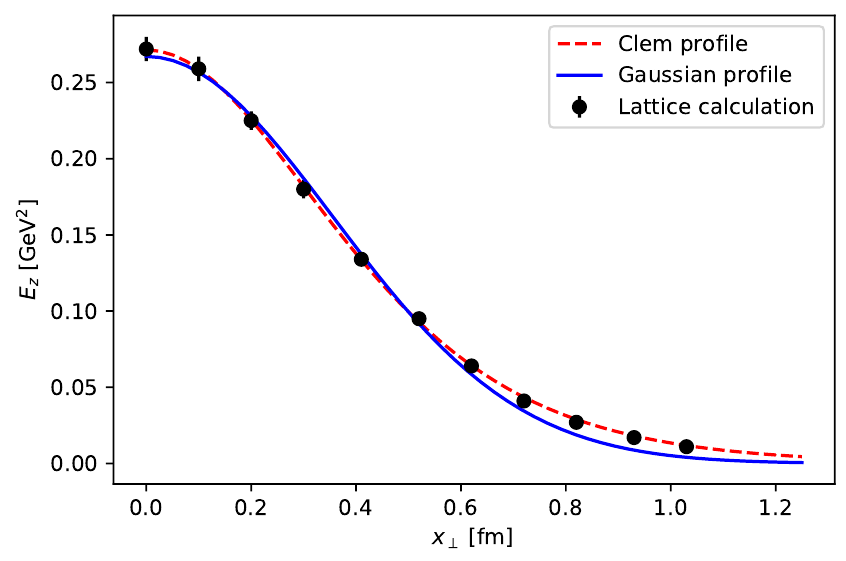
Figure 1 . Profile of the electric field from the lattice calculation in ref. [68] compared to the fit by Clem [71] and a Gaussian